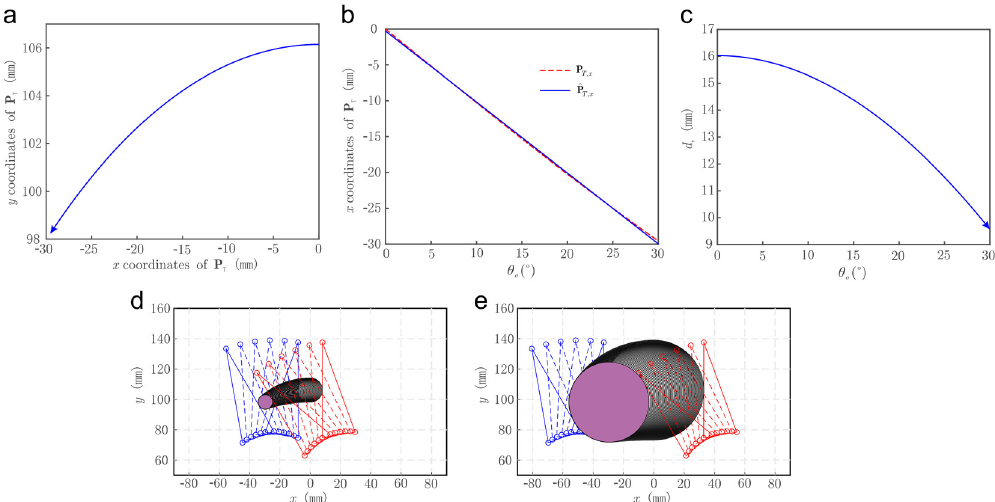
Figure 7. Multi-hand cooperative handling. ( a ) Movement trajectory of the object center, ( b ) Lateral displacement of the object center with respect to θ o , ( c ) Vertical distance between the two grasping surfaces, ( d , e ) Finger motion sequences with H x = 10 mm and 35 mm, respectively.